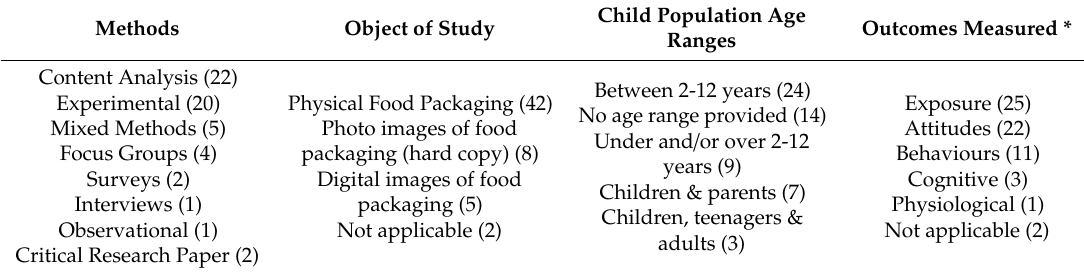
Table 1. Summary of main characteristics of included studies ( n =